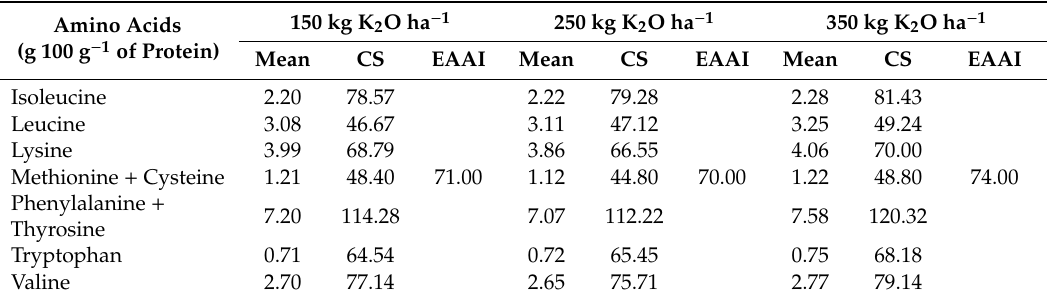
Table 7. The e ff ect of potassium fertilization on the nutritional value of protein in Jerusalem artichoke tubers. Amino